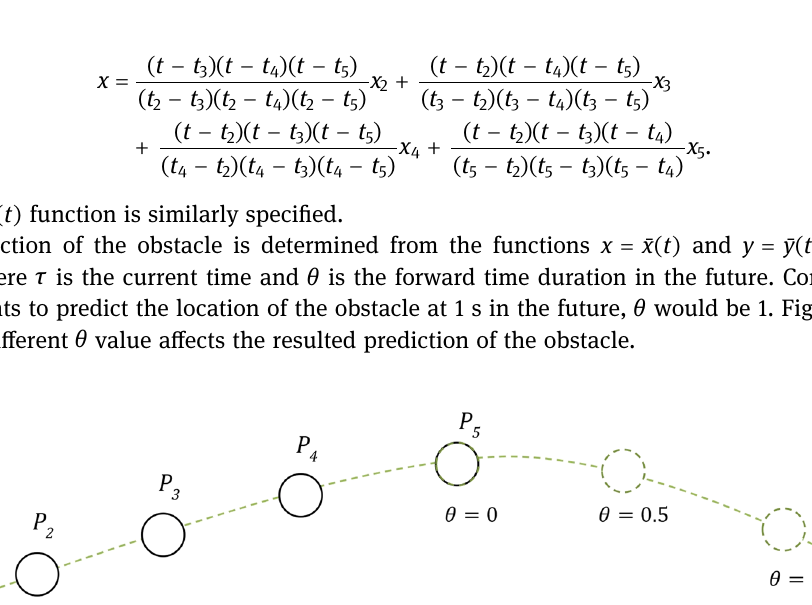
Figure 7: Resulted predictions with di ff erent θ